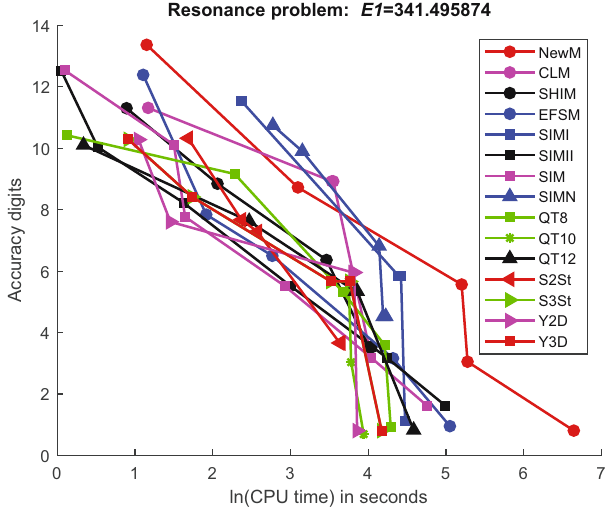
Figure 6: Methods e ffi ciency using E 341.495874 1 =